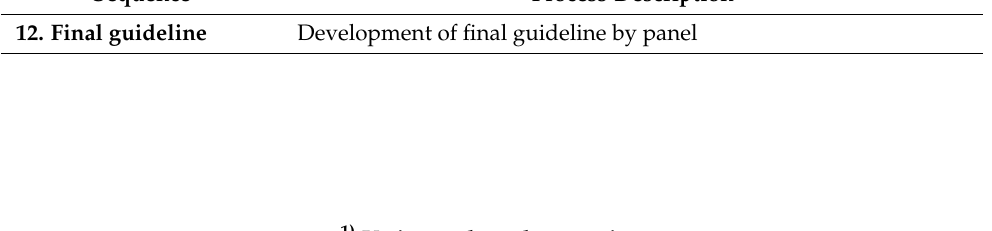
Table 1. Cont. Sequence Process Description 12. Final